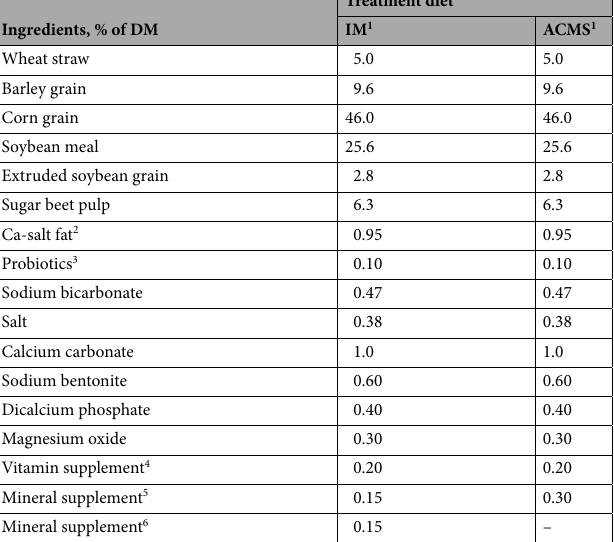
Table 2. Ingredients of ground starter feed. 1 ACMS advanced chelated mineral source, IM inorganic